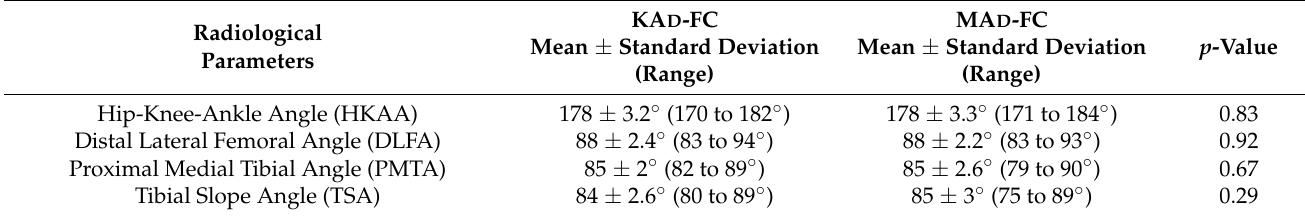
Table 4. Postoperative alignment radiological parameters. All units in